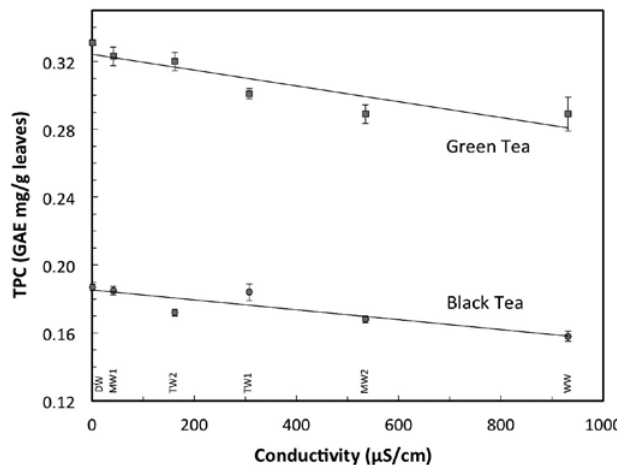
FIGURE 2 - Influence of water conductivity (µS/cm) on the total phenolic content (TPC), relative to TPC of gallic acid (GAE - gallic acid equivalent).